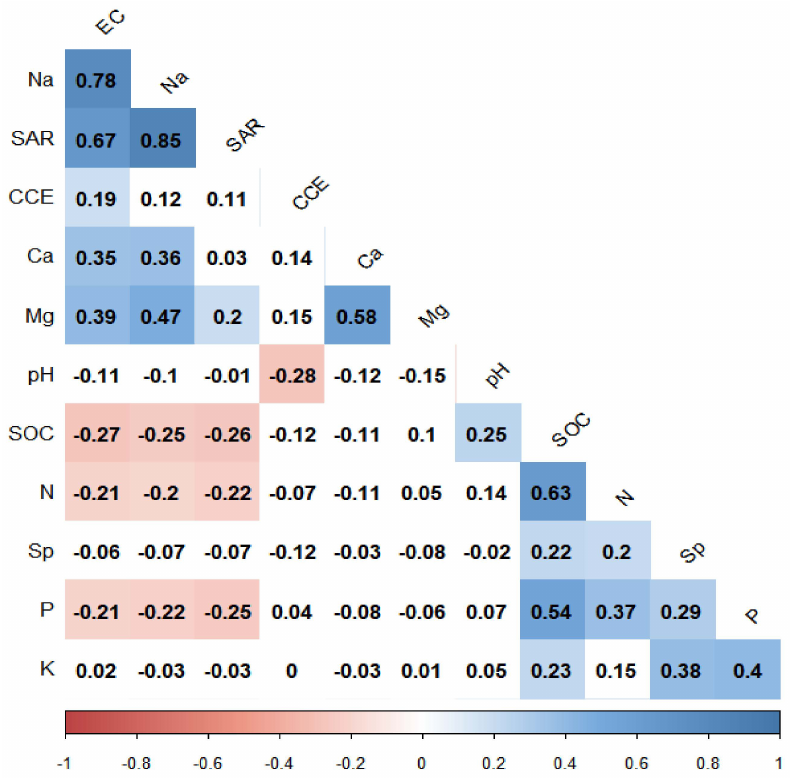
Figure 2. Pearson’s correlation coefficients between soil properties ( n = 223). Correlations with p > 0.01 are considered insignificant.